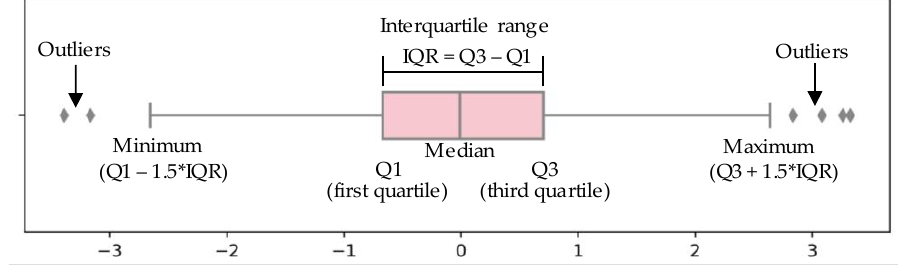
Figure 6. Boxplot outlier detection principle.